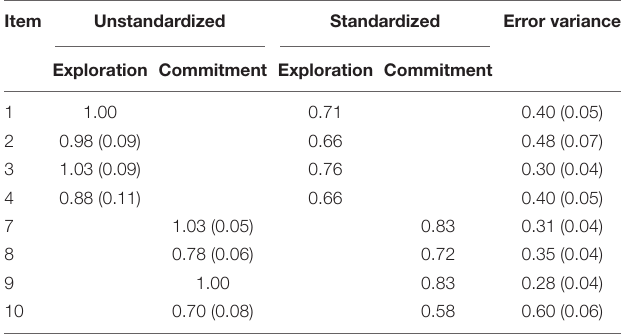
TABLE 7 | Confirmatory factor analysis factor loadings (standard errors) and unstandardized error variances (standard errors) for the two-factor model of the Doctoral Student Identity Scale ( n = 491).